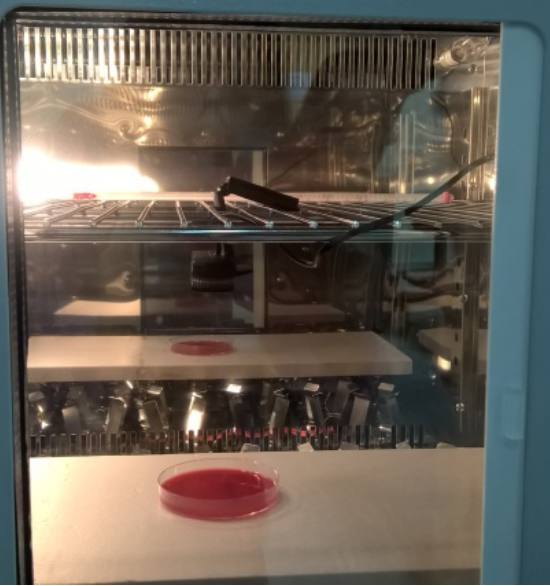
Figure 1. Experimental